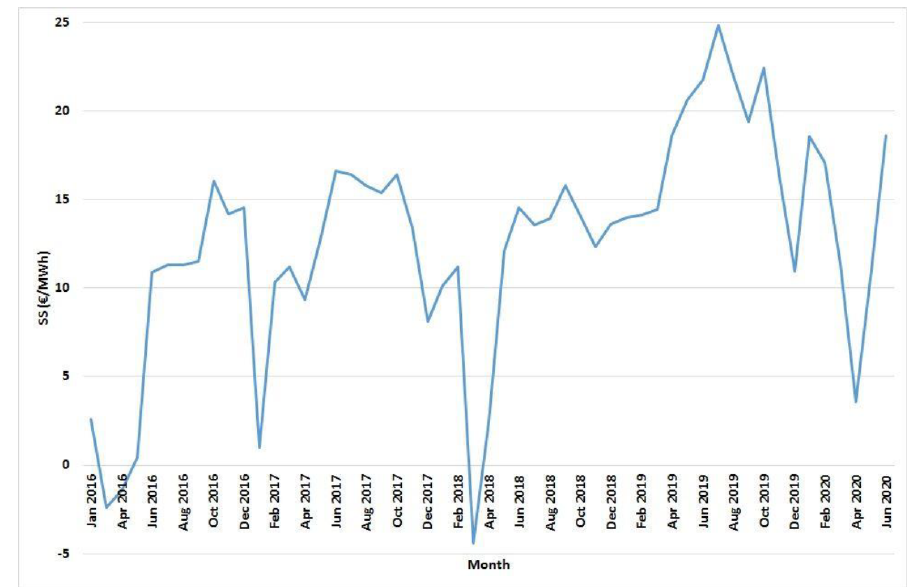
Figure 9. Monthly spark spread